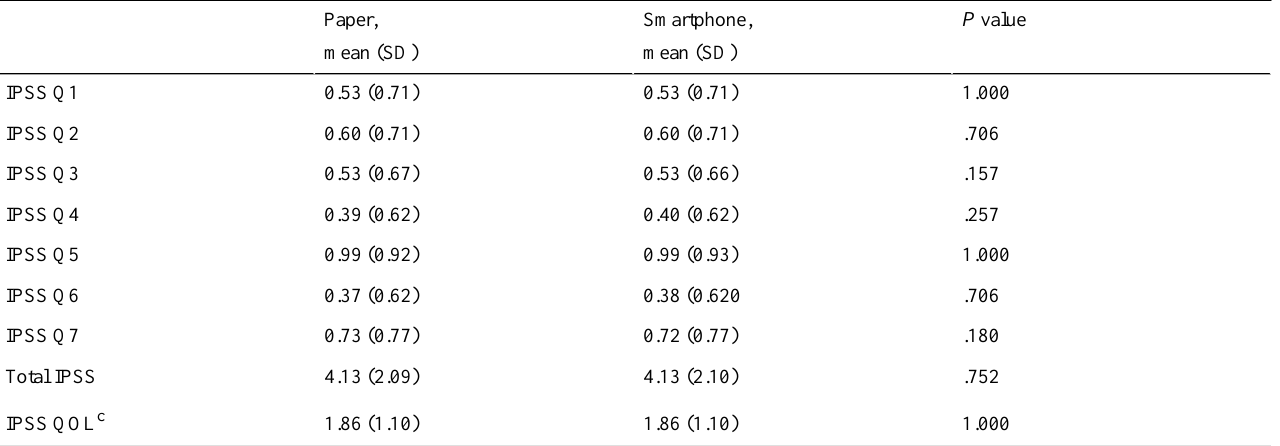
Table 3. Paired t test between paper and smartphone IPSS a in mild LUTS b